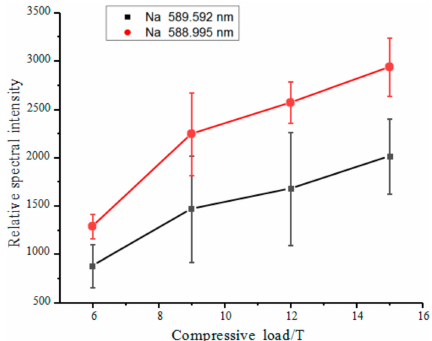
Figure 12. E ff ects of density on spectral